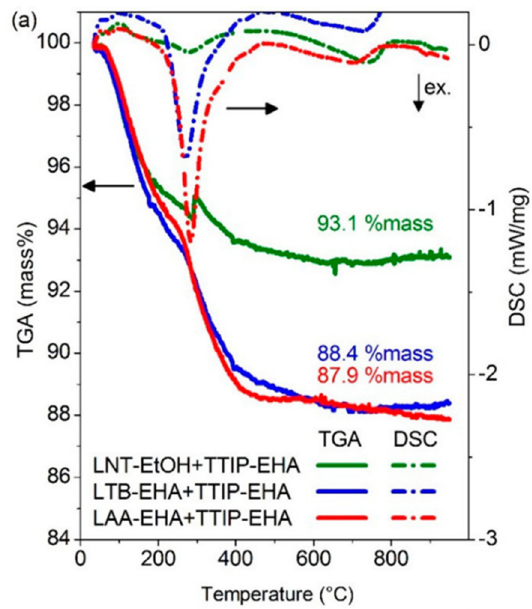
Figure 9. Results obtained from the coupling of TGA and DSC analysis, carried out in Li 4 Ti 5 O 12 particles produced through flame-spray pyrolysis (FSP), using various precursors and solvents [62]. Reproduced with permission from Meierhofer, F., et al., ACS Applied Materials & Interfaces; pub- lished by ACS publications, 2017.